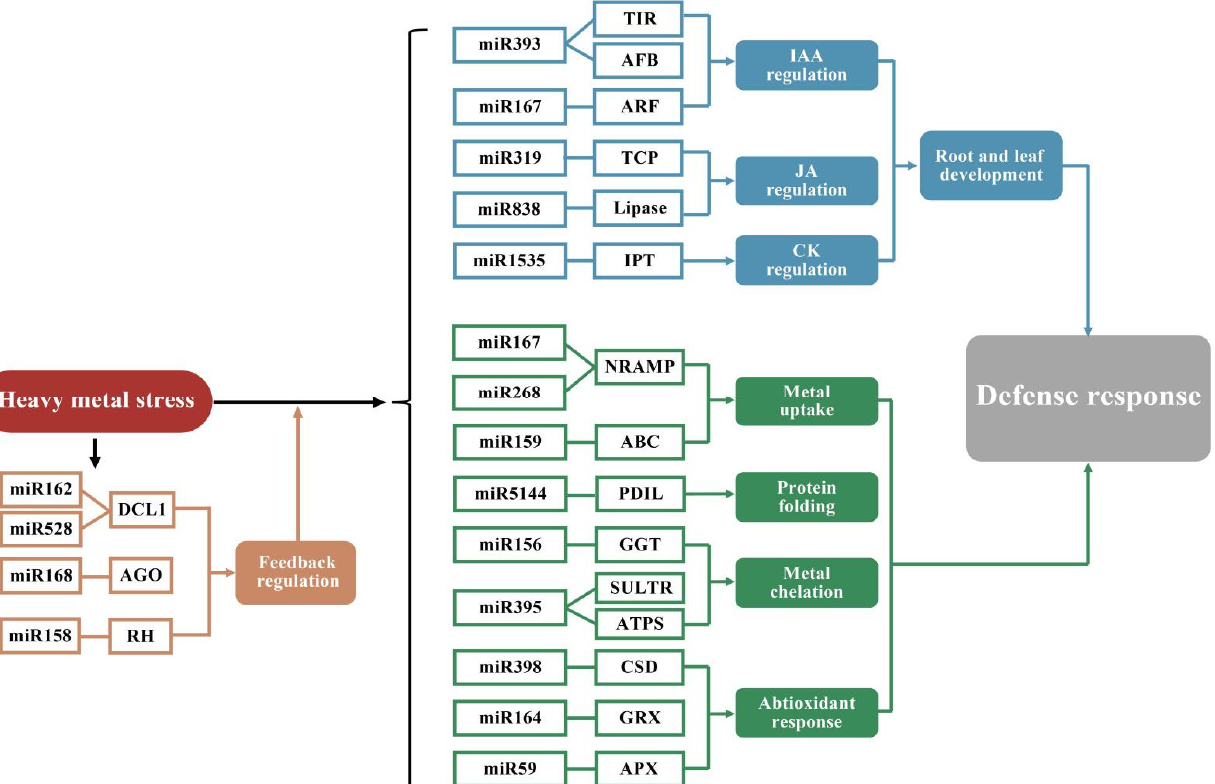
Figure 5. Regulatory networks of miRNA under HMS in plants. Feedback regulation of miRNAs under HMS in plants is indicated by orange letters and lines. Blue represents the regulation of hormone signaling that inhibits the growth of roots and leaves under HMS; green refers to the metabolic pathways involved in miRNA, including the uptake, transport and chelation of HMs and protein folding and antioxidation.